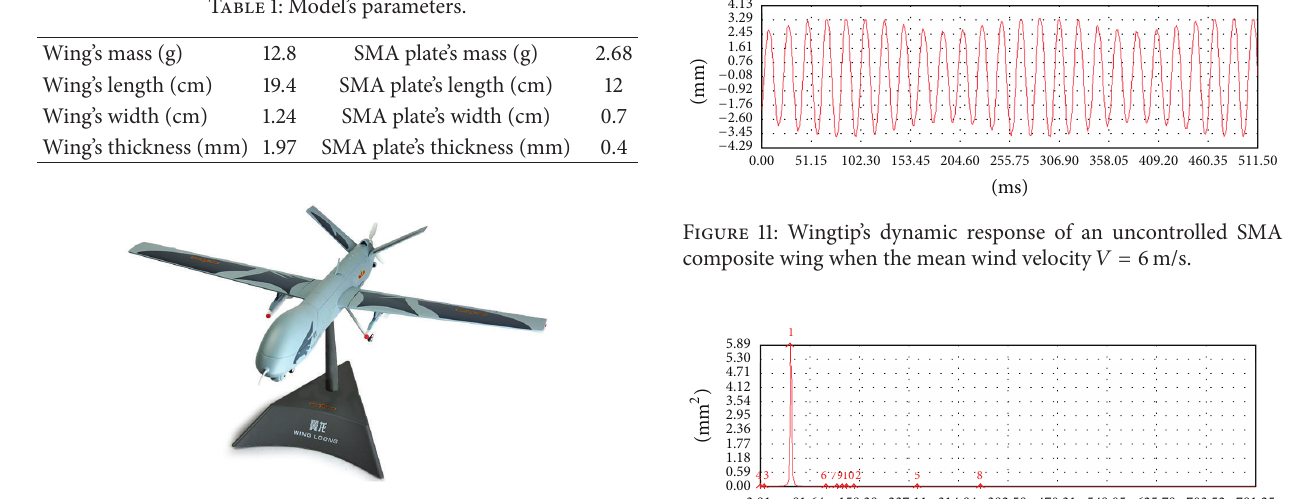
Figure 10: 1:14 Chinese “Wing Loong” UAV model.